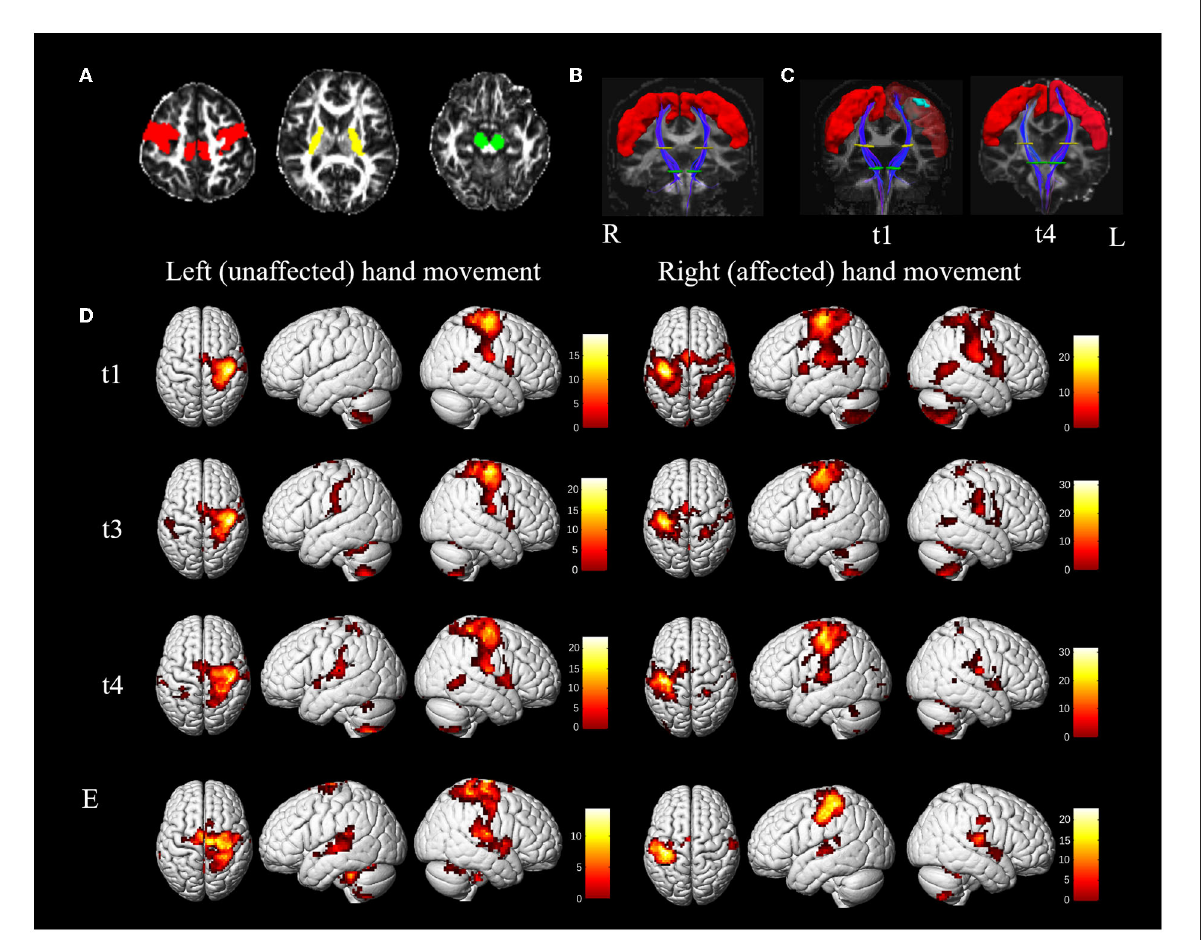
FIGURE2 MRI results. (A–C) , diffusion tensor tractography of the corticospinal tract (CST). (A) Regions of interest (ROI) for reconstructing the CST are located at the precentral gyrus (red color, obtained from the AAL90 template), the posterior limb of the internal capsule (yellow color), and the cerebral peduncle (green color) on the fractional anisotropic (FA) map. (B) A coronal view of the bilateral CSTs (blue color) from the healthy control. The red, yellow, and green areas represent the ROI of the precentral gyrus, the posterior limb of the internal capsule, and the cerebral peduncle. (C) A coronal view of bilateral CSTs from the patient at t1 (5 weeks) and t4 (45 weeks). On the left of the C map (t1), the cyan region is the lesion registered from T1 space to FA space. (D,E) activation during passive unaffected (left) and affected (right) hand movements of the patient and healthy control. (D) Activation of passive movement of the patient at t1, t3 (12 weeks), and t4; (E) activation of passive movement of healthy control. Color bar = t -value. The left side indicates the left hemisphere. L, left; R,